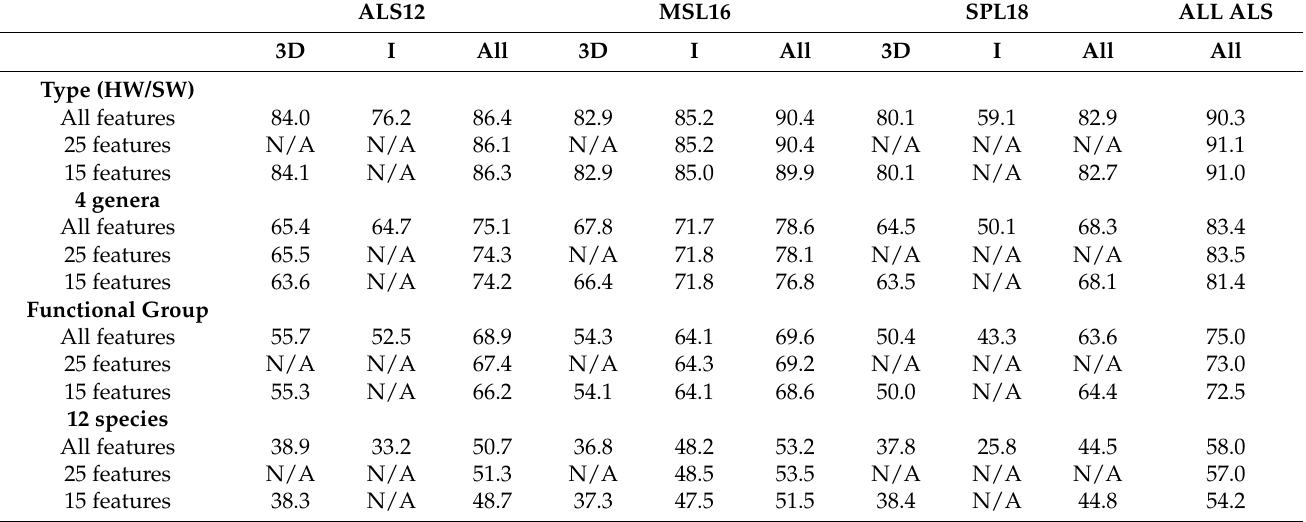
Table 6. Random Forest classification accuracy in % (20 runs) broken down by 3D and intensity (I) features, pooled by system (All), and pooled across all systems and features (ALL ALS,